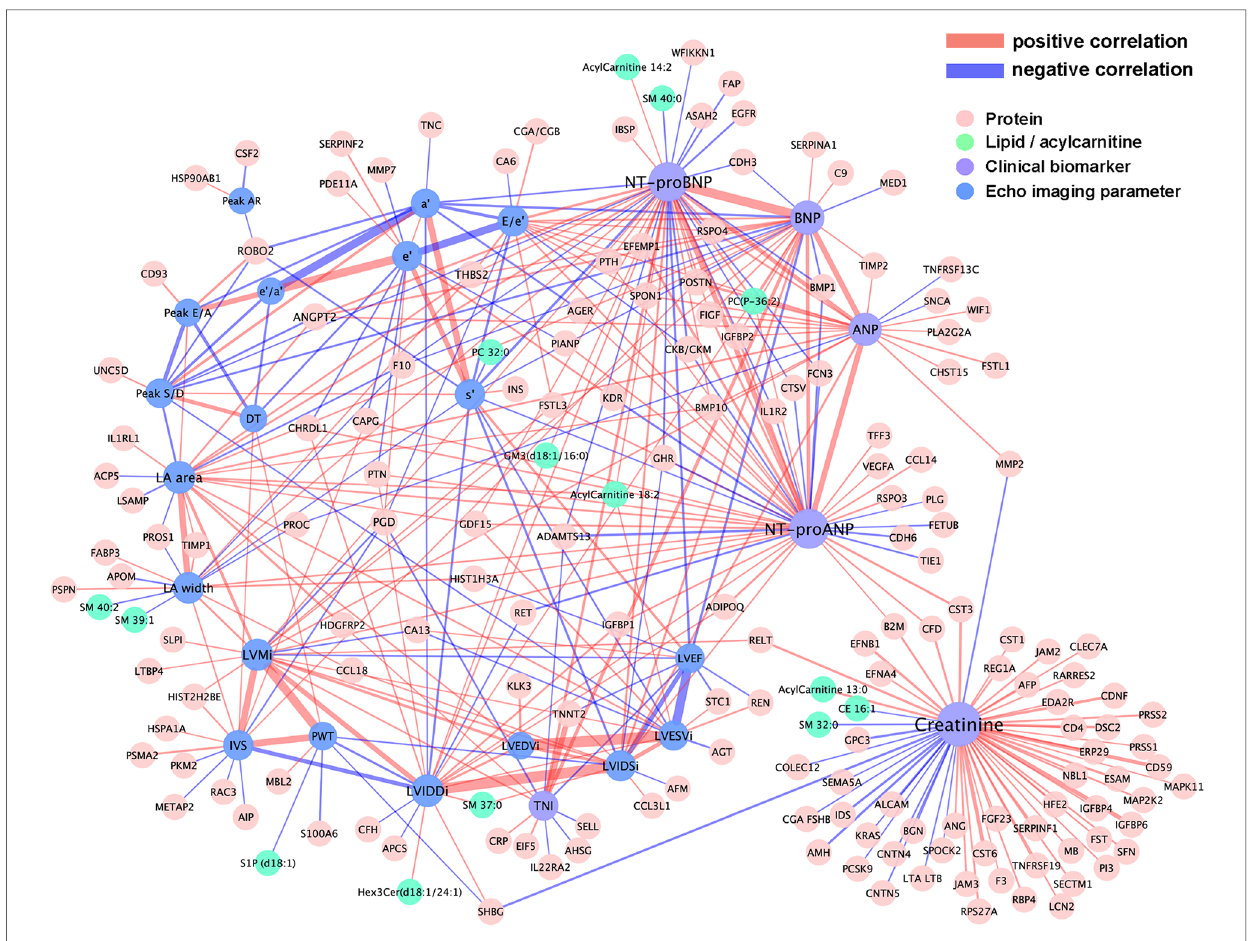
FIGURE 2 Visualization of the partial correlation network connecting plasma proteins and lipids with echocardiographic imaging variables and cardiac biomarkers. Plasma proteins and lipids were drawn as nodes in light red and cyan, and echocardiographic variables and cardiac biomarkers in blue and light purple, respectively. Network edges were colored according to the signs of partial correlations, i.e. positive in red and negative in light